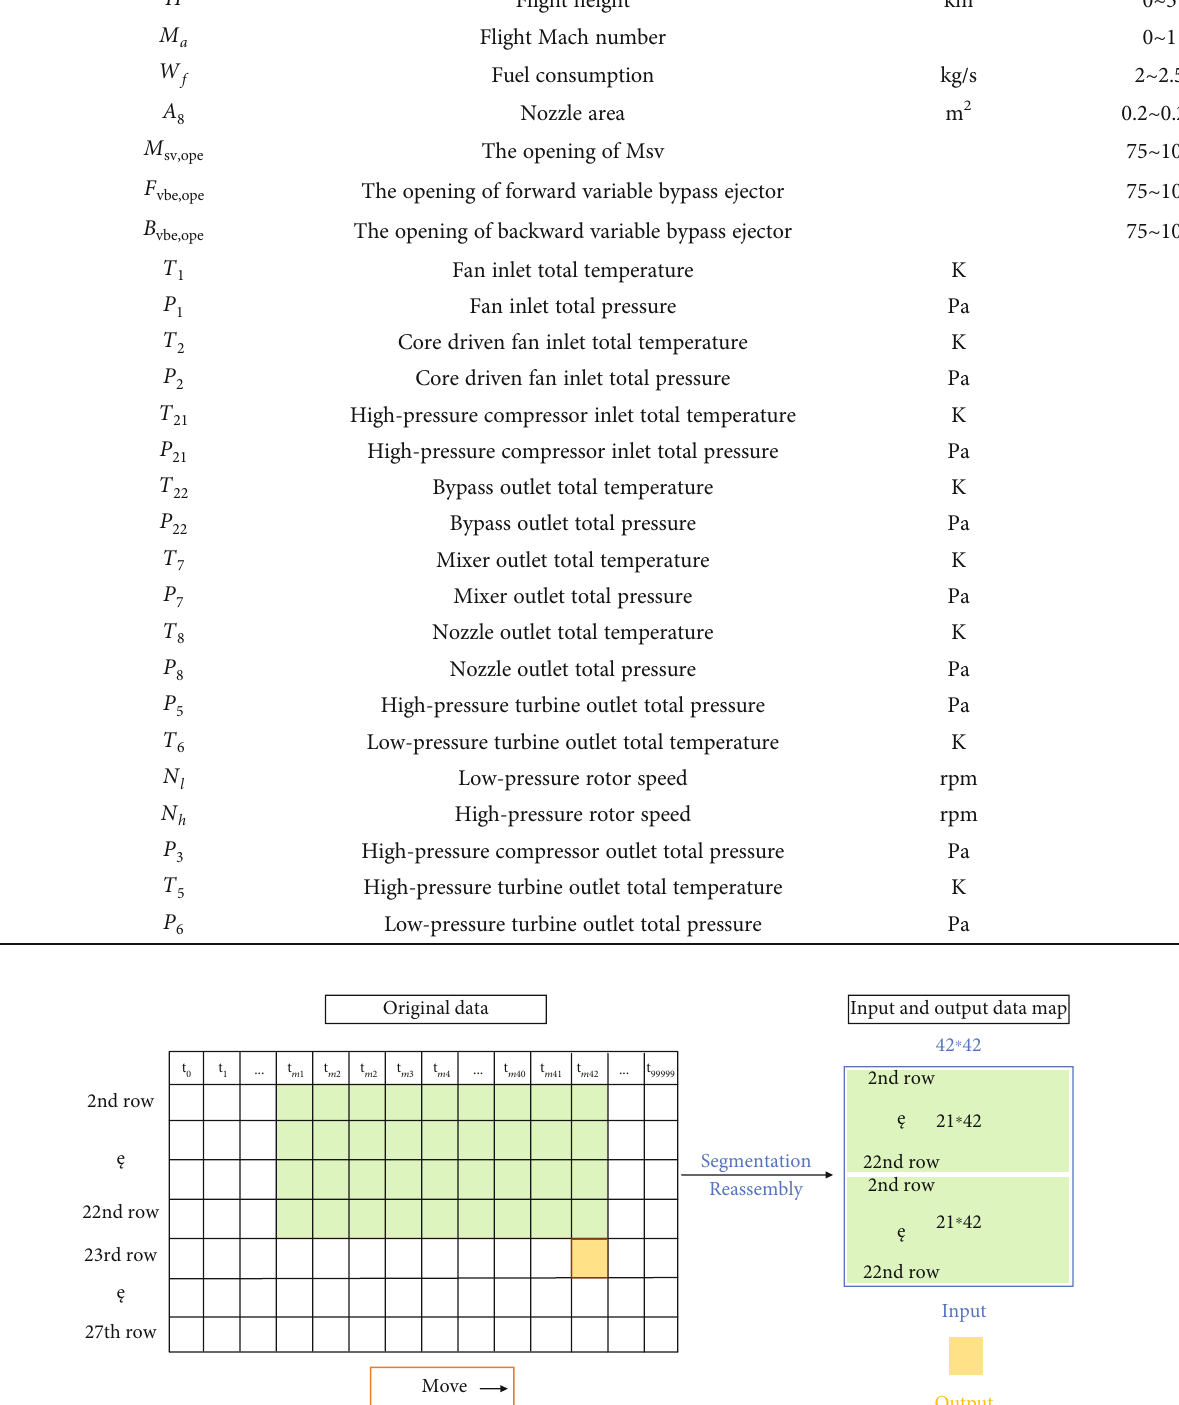
Figure 2: Segmentation and reassembly of the original data